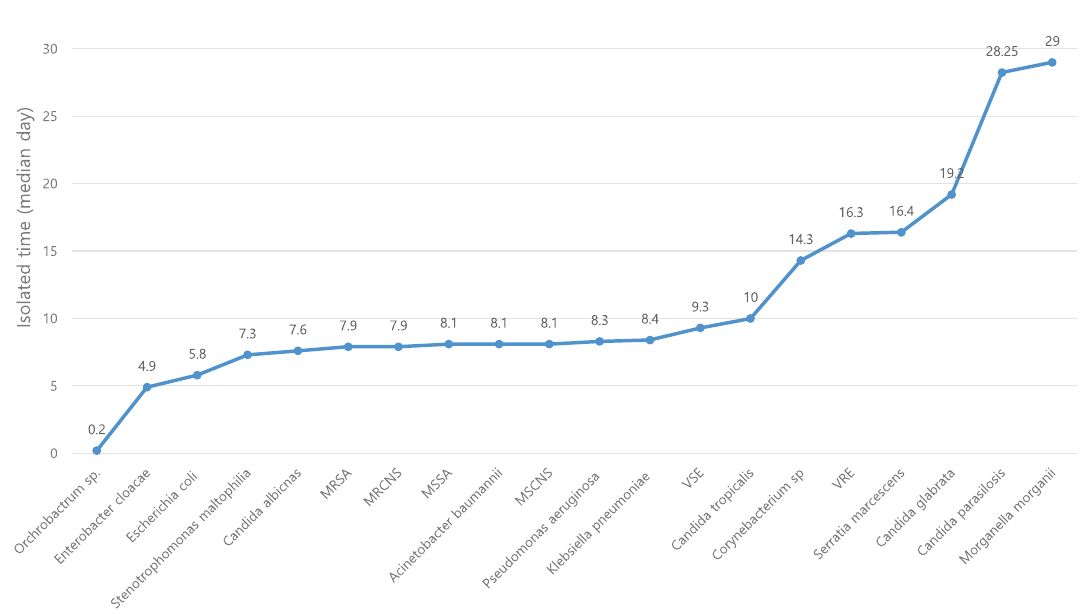
Figure 4. Type of organisms isolated in chronologic order. MRSA Methicillin-resistant Staphylococcus aureus , MRCNS Methicillin-resistance coagulase negative Staphylococci , MSSA Methicillin-sensitive coagulase negative